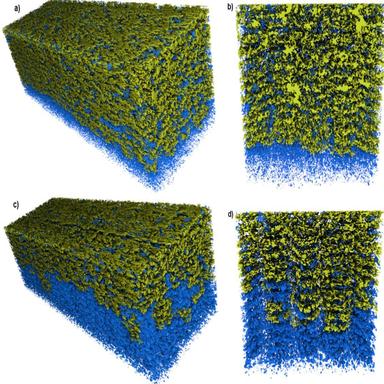
3D visualisations of segmented images of a) and c) the entire sample scanned and b) and d) a smaller subset, for Victrex 3D (top) and L&V 3D (bottom), showing in yellow/green all the voids which are mutually connected within the microstructure and in blue the rest of the voids. (For interpretation of the references to colour in this figure legend, the reader is referred to the web version of this article.)